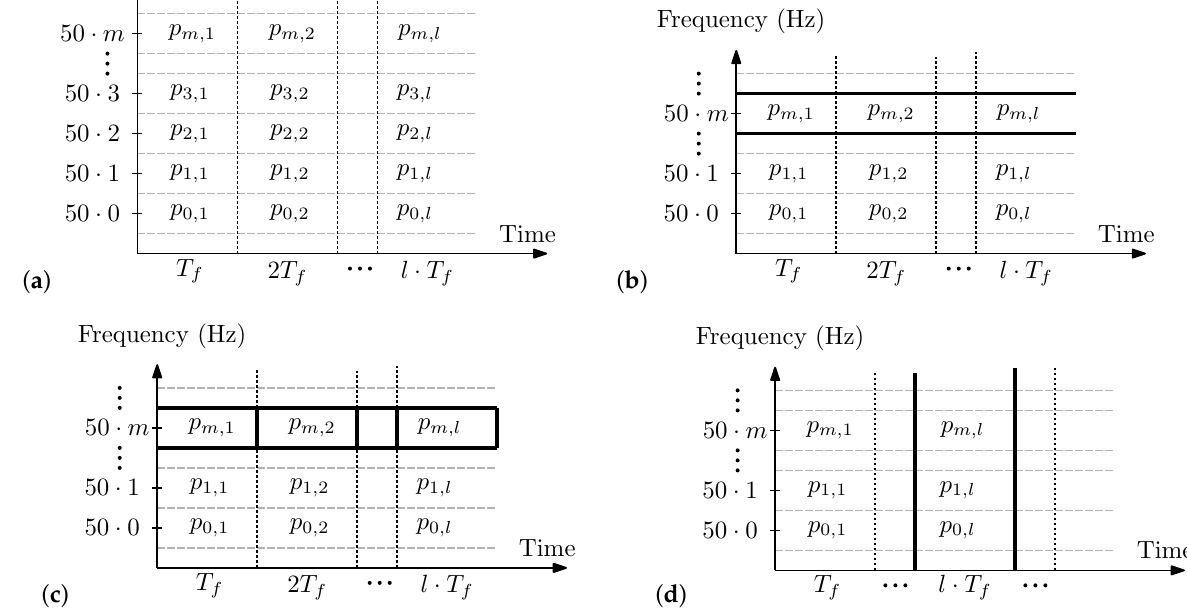
Figure 2. The analysis of a harmonics signal is based on the spectrogram concept, with power p m , l of l -th frame and m -th harmonic: ( a ) harmonics value for each time-frame; ( b ) statistics of m -th harmonic for all frames; ( c ) inter-harmonics relation; ( d ) intra-harmonics